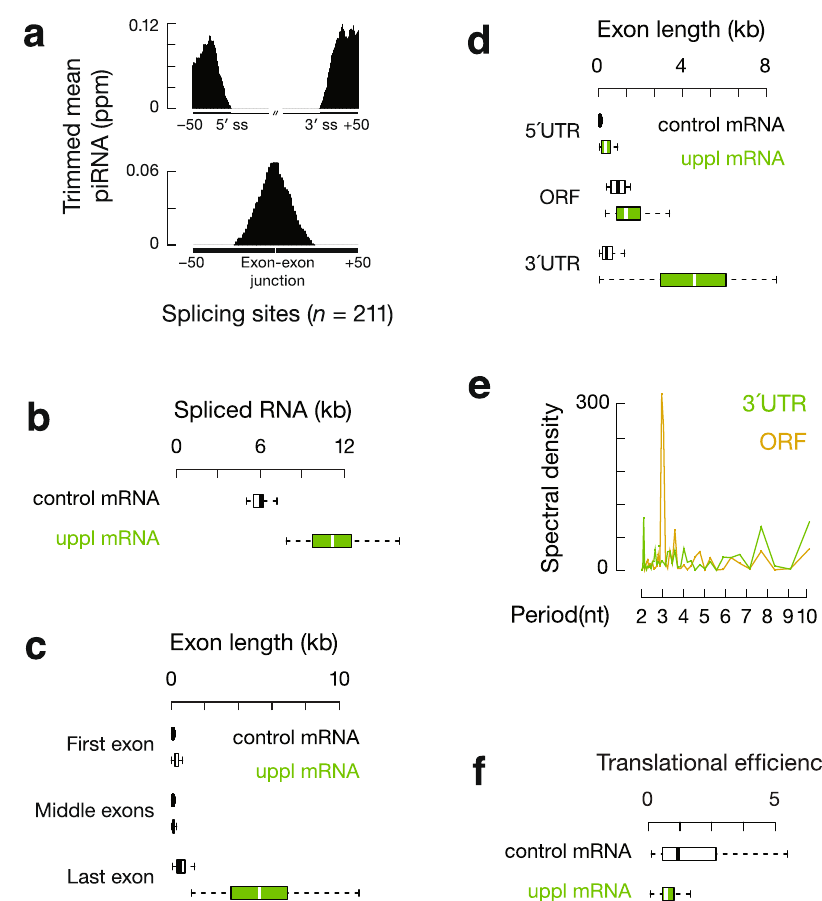
Fig. 2 Translation and piRNA processing are coupled on uppl mRNAs. a Top, aggregation plots of piRNA reads surrounding the 5 ′ and 3 ′ splice sites of uppl mRNAs from the adult mouse testes. Bottom, the signal was calculated for non-genome matching piRNA reads mapping to exon – exon junction sequences. b Boxplots showing spliced RNA transcript length distributions. Control mRNA n = 43, uppl mRNA n = 30. c Boxplots showing exon length distributions. Control mRNA fi rst or last exon n = 43, uppl mRNA fi rst or last exon n = 30. Control mRNA middle exon n = 145, uppl mRNA middle exon n = 69. d Boxplots showing ORF and UTR length distributions. Control mRNA n = 43, uppl mRNA n = 30. e Discrete Fourier transformation of the distance spectrum of 5 ′ -ends of RPFs across ORFs (gold) and 3 ′ UTRs (green) of uppl mRNAs in adult wild-type testes. f Boxplots showing translational ef fi ciency (RPF abundancy divided by mRNA abundancy) in adult wild-type testes. Control mRNA n = 43, uppl mRNA n = 30. Box plots in ( b – d and f ) show the 25th and 75th percentiles, whiskers represent the 5th and 95th percentiles, and midlines show median